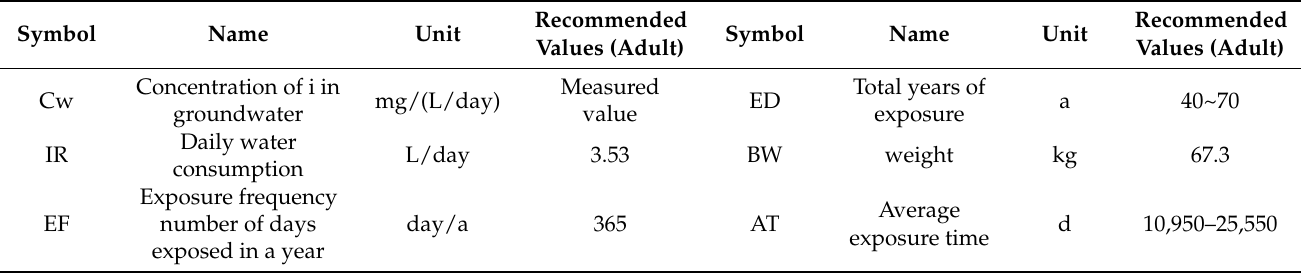
Table 3. Relevant parameters of health risk